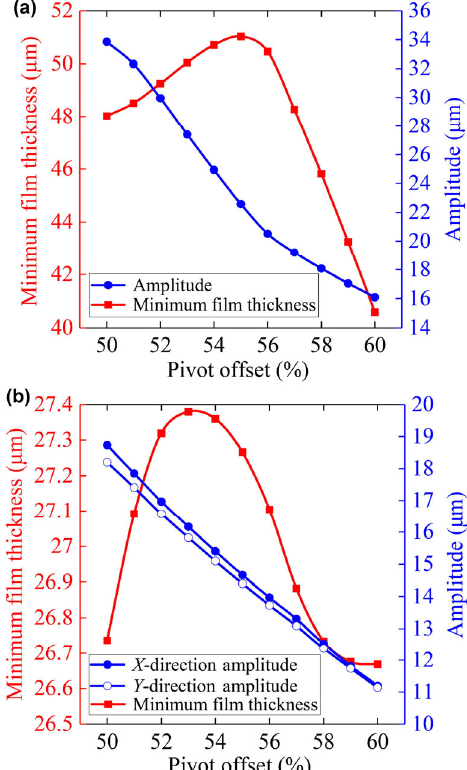
Fig. 7 Minimum film thicknesses and journal amplitudes of TPJBs (a) without and (b) with static loads as a function of pivot offsets.